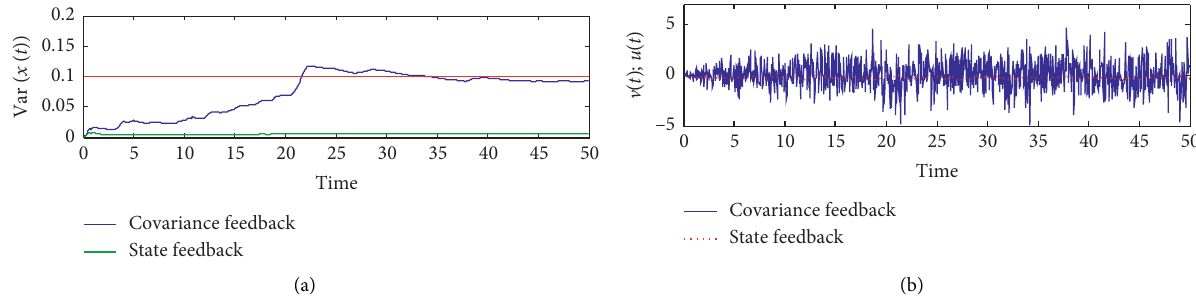
Figure 4: State variance and control signal of controlled system with proposed controller and state feedback approach [9]: (a) covariance tracking problem; (b) control